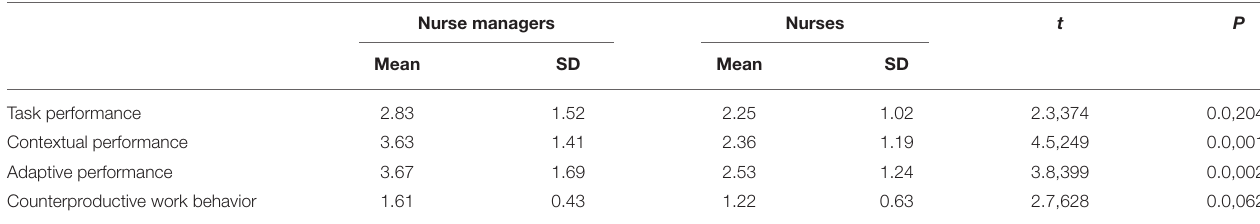
TABLE 4 | Nurse managers’ and staff nurses’ perceptions of job